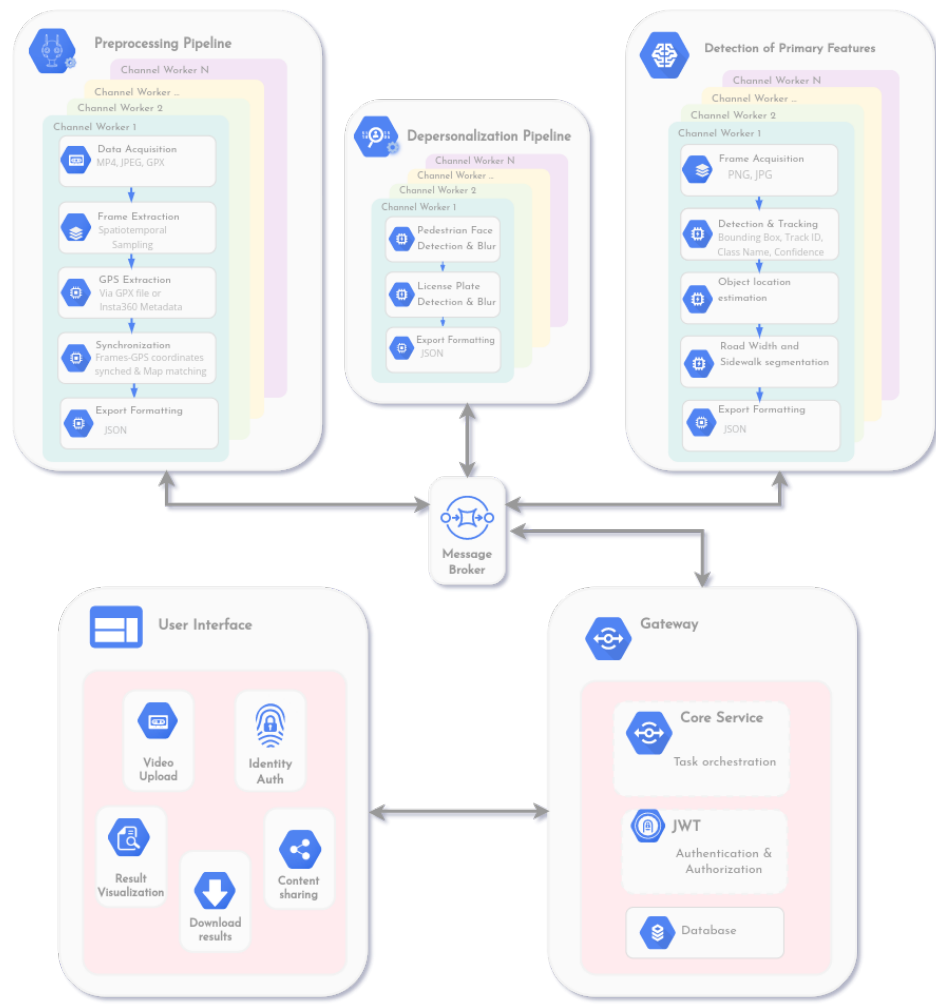
Figure 5. A schematic representation of StreetScouting platform